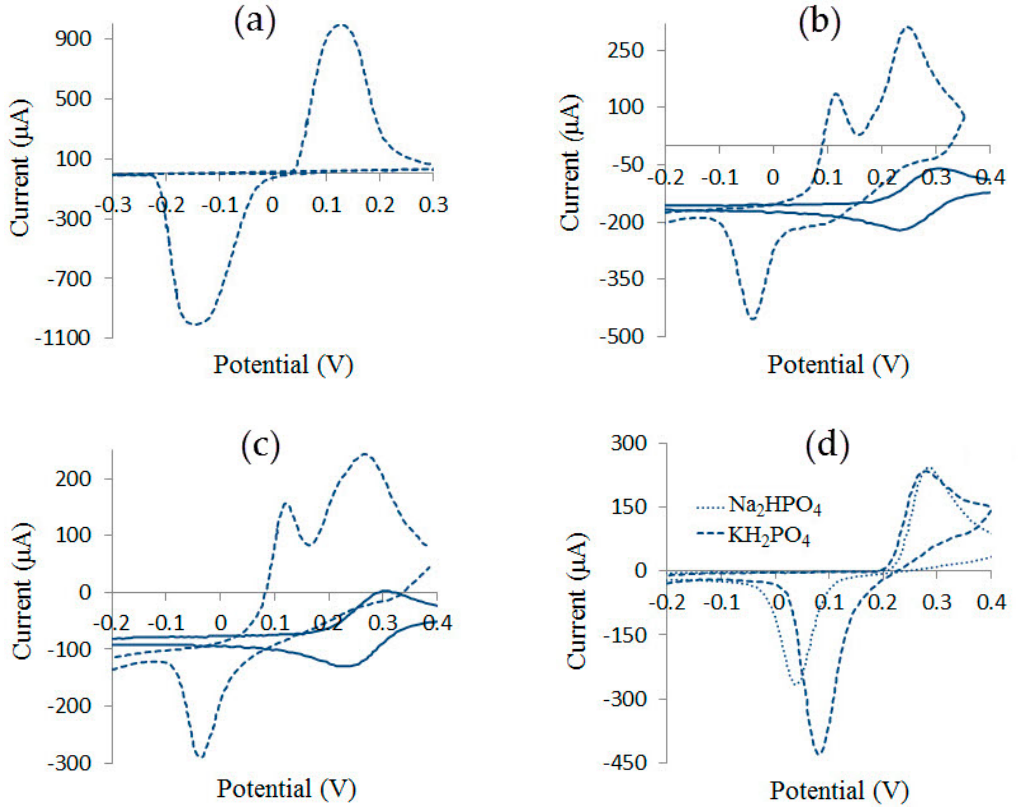
Figure 2. Cyclic voltammograms recorded on AgSPE (dashed lines, first cycle) and Pt (solid lines) in solutions of ( a ) 1 M KCl, ( b ) 0.005 M K 4 [Fe(CN) 6 ] and 1 M KNO 3 , ( c ) 0.005 M K 3 [Fe(CN) 6 ] and 1 M KNO 3 , ( d ) 0.005 M Na 2 HPO 4 with 1 M KNO 3 and 0.005 M KH 2 PO 4 with 1 M KNO 3 . Scanning rate 0.05 V / s.